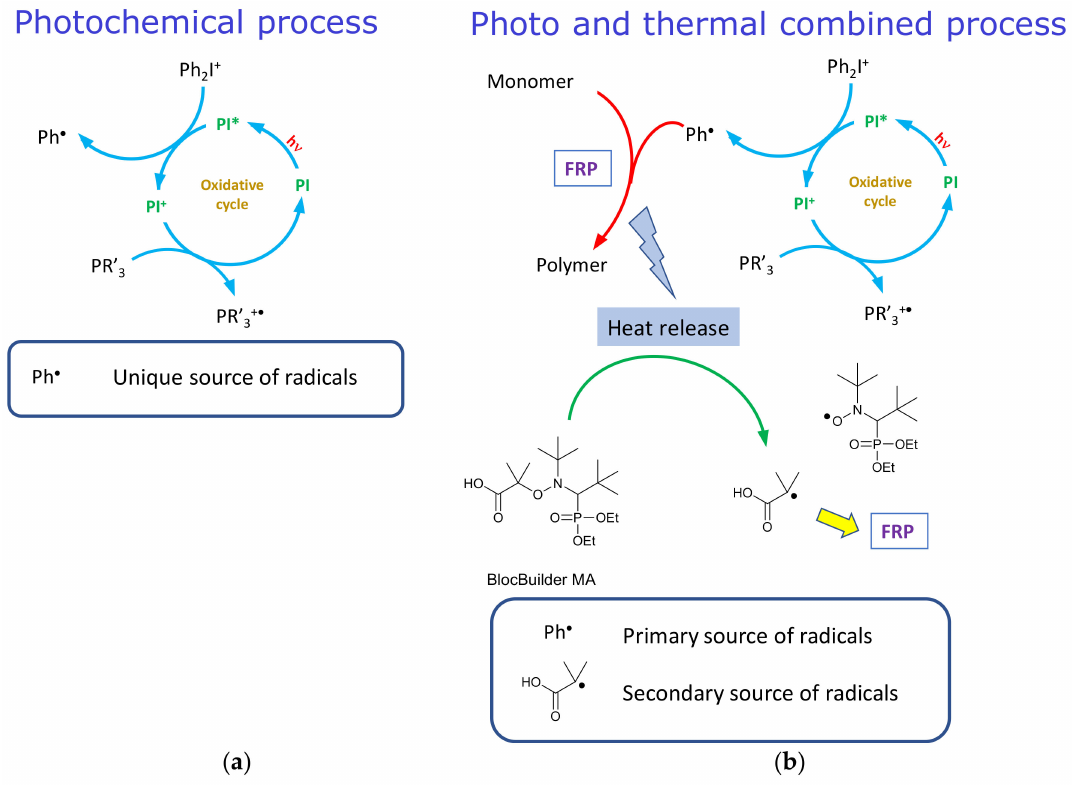
Figure 12. Comparison of pure photochemical ( a ) and combined photochemical and photothermal processes ( b